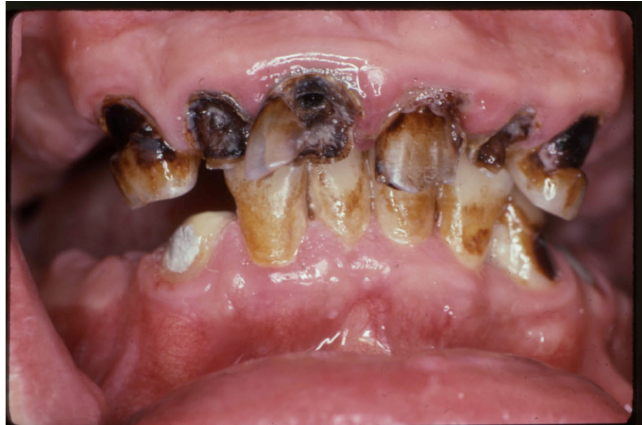
Figure 4. A 65-year-old male is brought for treatment by a social worker as he is in pain. The patient is currently being treated for alcoholism and drug misuse in a hospital setting. He has no family members with whom he is in contact and has been homeless for the last five years. His health history includes smoking a pack of cigarettes a day, hypertension, type II diabetes, osteoporosis, and osteoarthritis. He had not been medicated before hospitalization and is currently receiving naltrexone to help him manage his alcoholism. He is also currently taking an oral antidiabetic, a calcium channel blocker, a thiazide diuretic, and a non-steroidal anti-inflammatory agent. An oral examination revealed multiple carious lesions and root tips, with a sinus tract associated with a mandibular left second premolar root tip, which is the probable cause of his oral pain. The prognosis for his remaining teeth is very poor, and he will need help to find funding for his oral treatment needs. His immediate treatment is the extraction of the infected root tip. This patient represents a person who has many important risk factors, and to whom rapid oral health deterioration has already